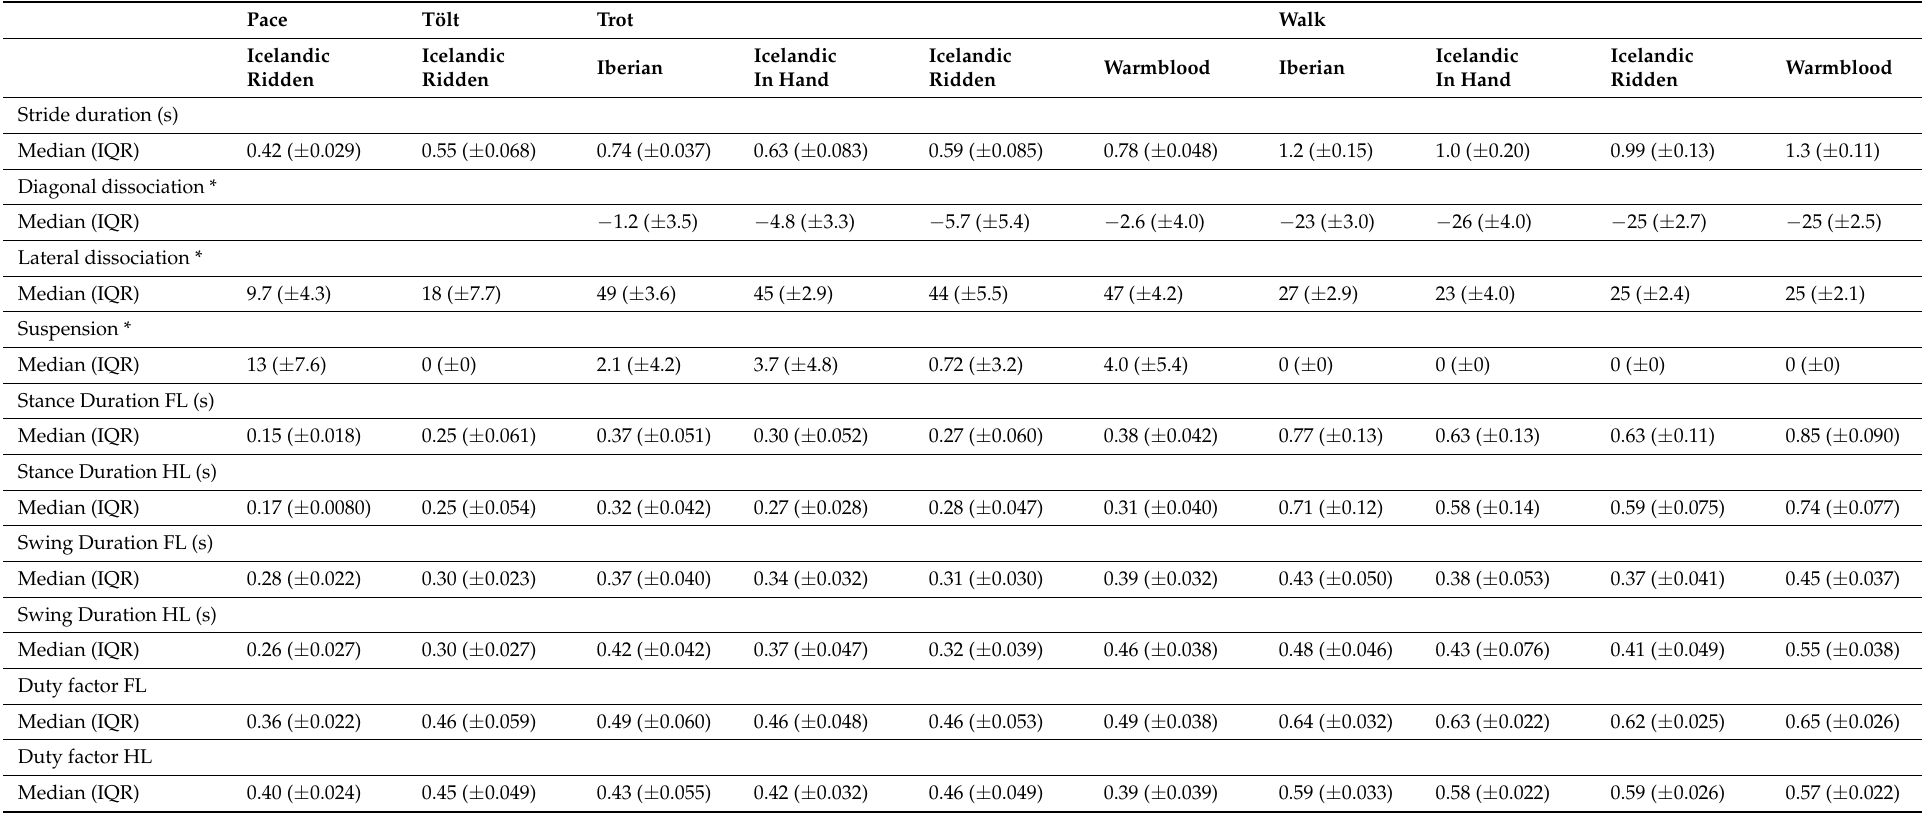
Table 1. Stride parameters (median and interquartile range (IQR)) for each breed, gait and condition (ridden/in hand). N: number of horses in each category, WB: Warmblood horses. * as % of stride duration; FL: forelimbs, HL: hind limbs. Diagonal dissociation was not calculated for pace and